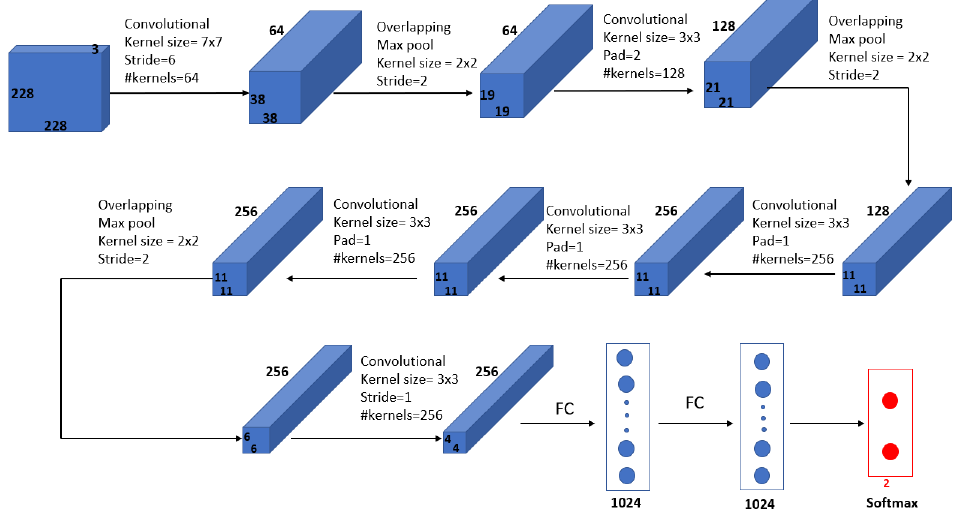
Figure 10. Architecture of the proposed CNN model in